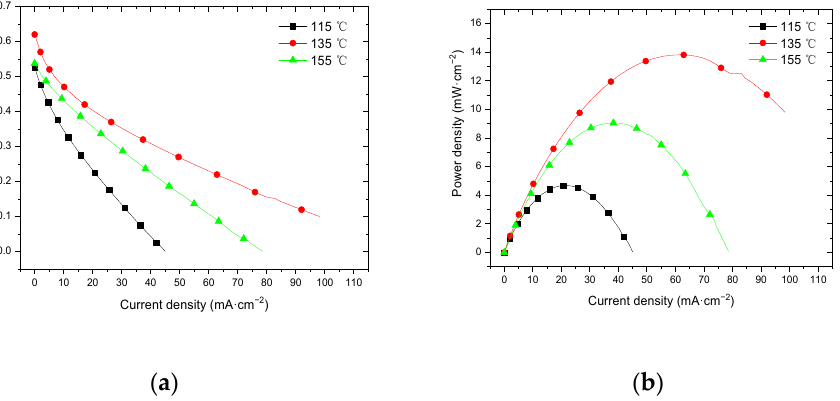
curve between current density and power density. ( b )